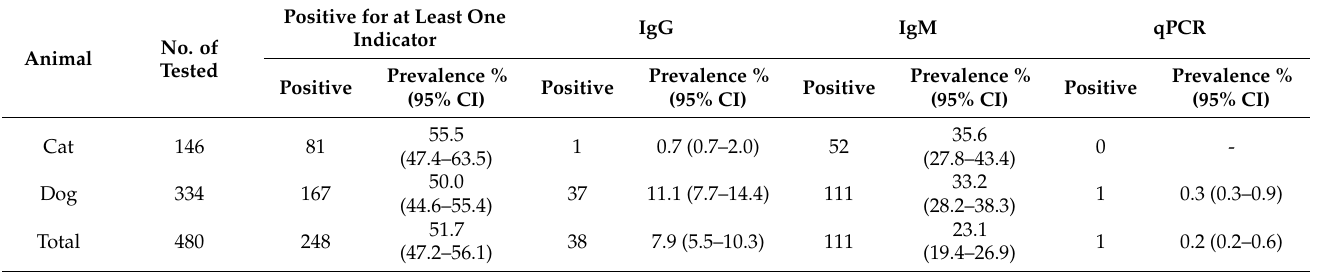
Table 3. Coinfection with T. gondii and N. caninum in stray cats and dogs in the QTPA, China.